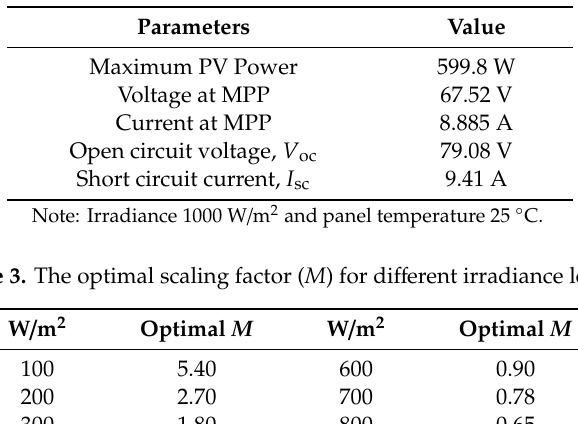
Table 2. Specifications of the utilized Photovoltaic Module.